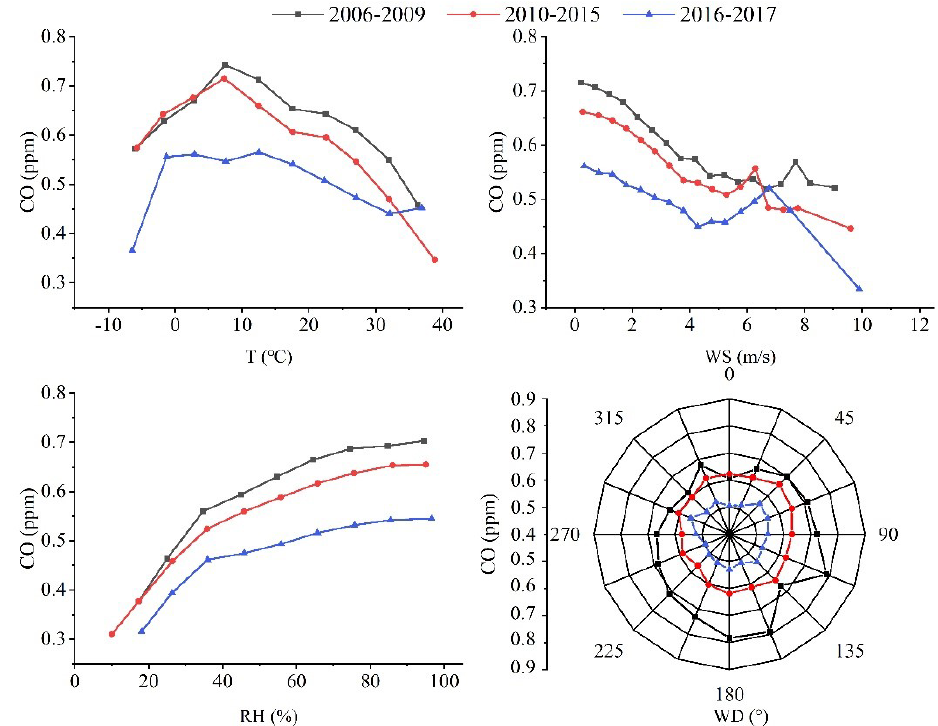
Figure 10. Variations in CO mixing ratios in different periods with respect to temperature ( T ), wind speed (WS), relative humidity (RH), and wind direction (WD). The intervals are 5 ◦ , 0.5m/s, 10%, and 22.5 ◦ for T , WS, RH, and WD, respectively.